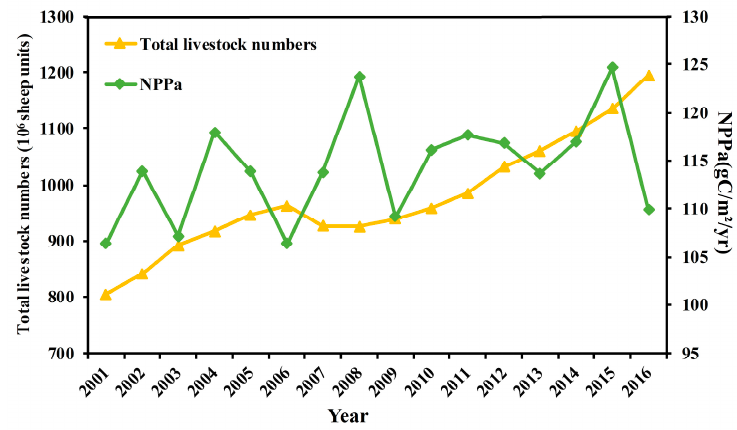
Figure 8. The dynamics of NPP a and livestock numbers from 2001 to 2016 in Qinghai province. 320